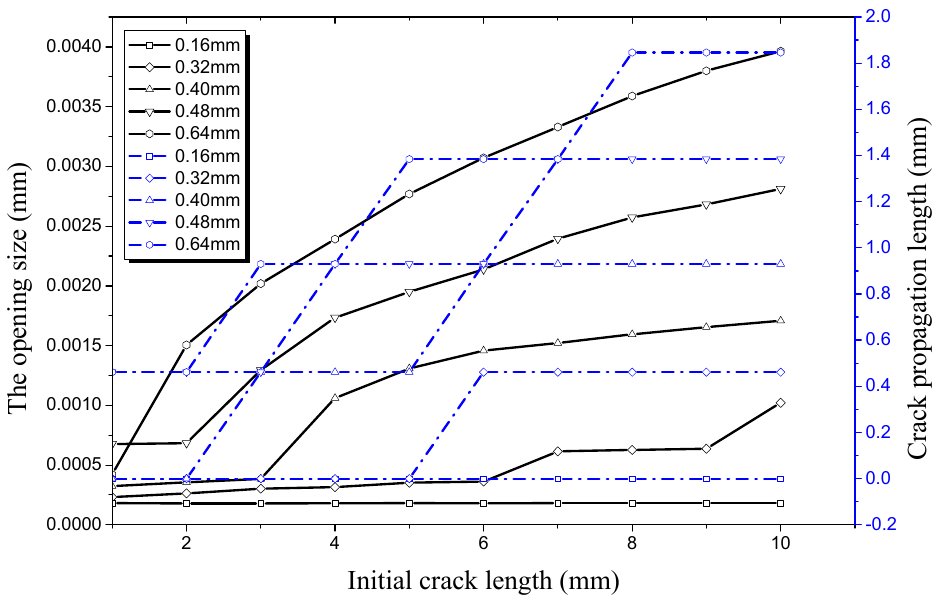
Figure 21. Relationship between longitudinal crack propagation length and initial crack length on the inner surface, and relationship between longitudinal opening size and initial crack length on the inner surface, both under an internal pressure of 28 MPa.